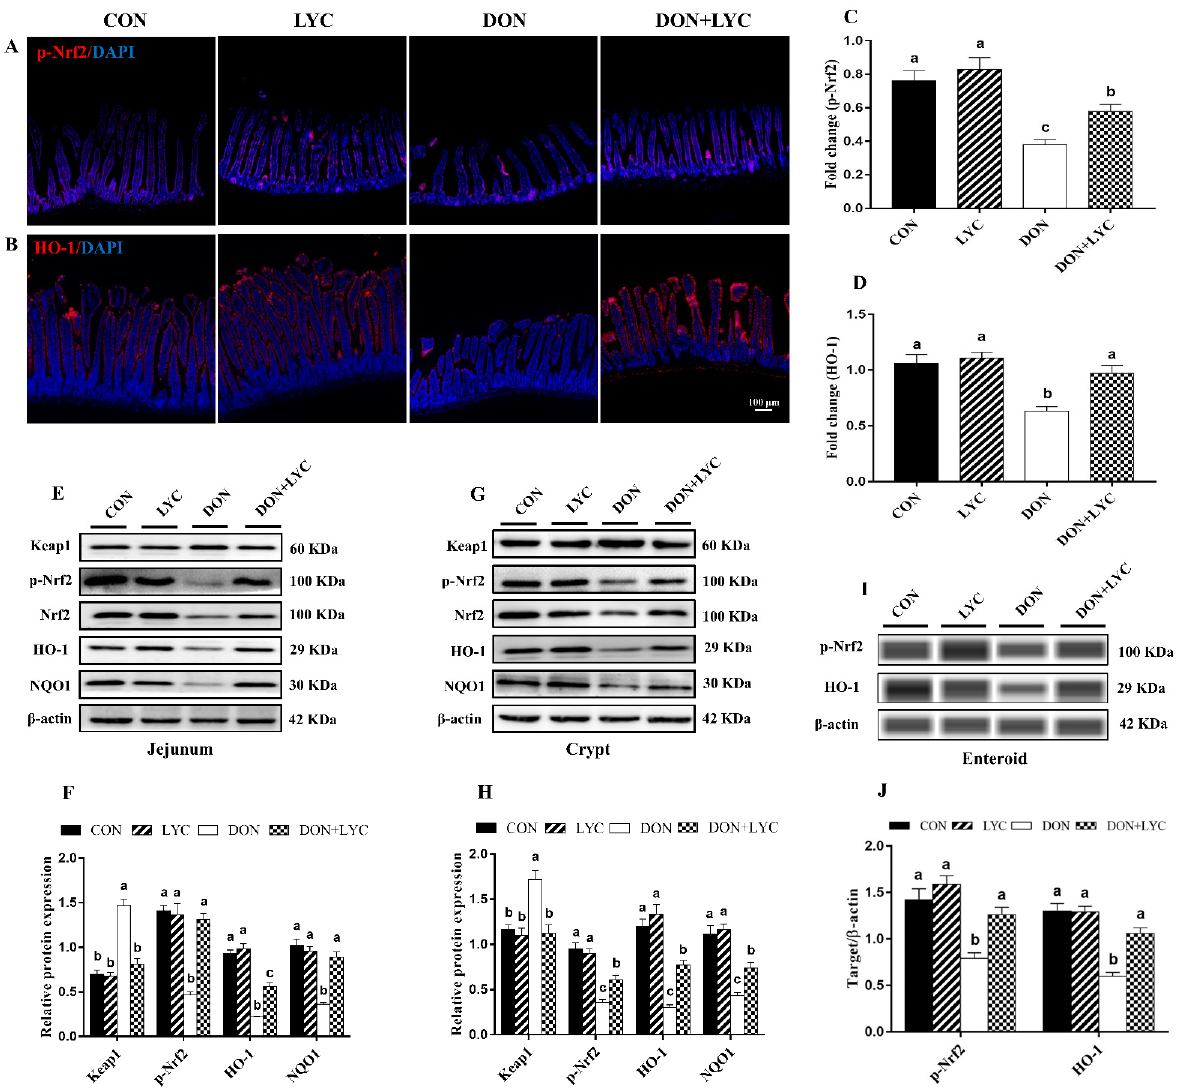
Figure 6. LYC treatment promoted DON-induced Nrf2 signaling activation via down-regulation of Keap1. ( A , B ) Repre- sented images of immunohistochemistry staining with p-Nrf2 and HO-1 antibodies in the jejunum of mice. ( C , D ) Statistical analysis of the fluorescence intensity of p-Nrf2 and HO-1. ( E , F ) Protein expression of Keap1, p-Nrf2, Nrf2, HO-1, and NQO1 in the jejunum. ( G , H ) Protein expression of Keap1, p-Nrf2, Nrf2, HO-1, and NQO1 in the crypt. ( I , J ) Protein expression of p-Nrf2 and HO-1 in the enteroids of mice. All the data are expressed as mean ± SEM ( n = 3). Columns with different superscripts letters indicating significant difference ( p <